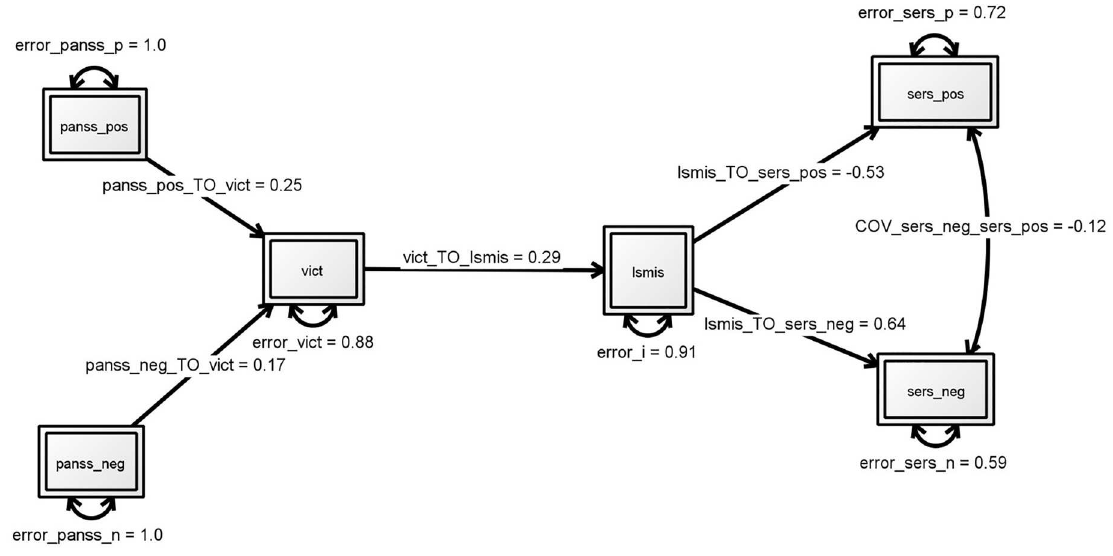
negative symptoms ( β = .0.18, p = 0.07). The third model with a direct effect for negative symp- toms on self-stigma and an indirect effect for positive symptoms mediated by victimization, again fitted the data well (see Fig 3 and Table 2). Where negative symptoms are directly related to self-stigma ( β = .0.27, p < 0.01), for positive symptoms the effect is mediated by victimization ( β = .29, p < 0.01). However, based on a comparison of the goodness of fit indices, this modifi- cation showed not to be an improvement over the original hypothesized model (AIC, from 3602.784 to 3610.505).